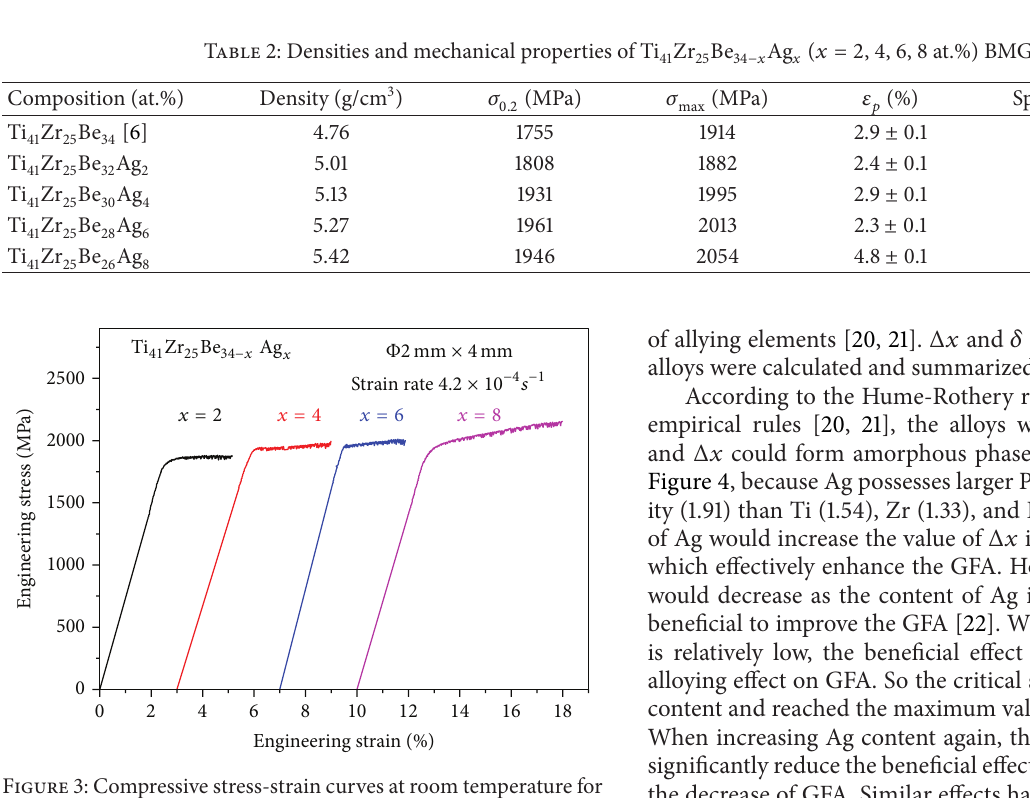
Table 2: Densities and mechanical properties of Ti